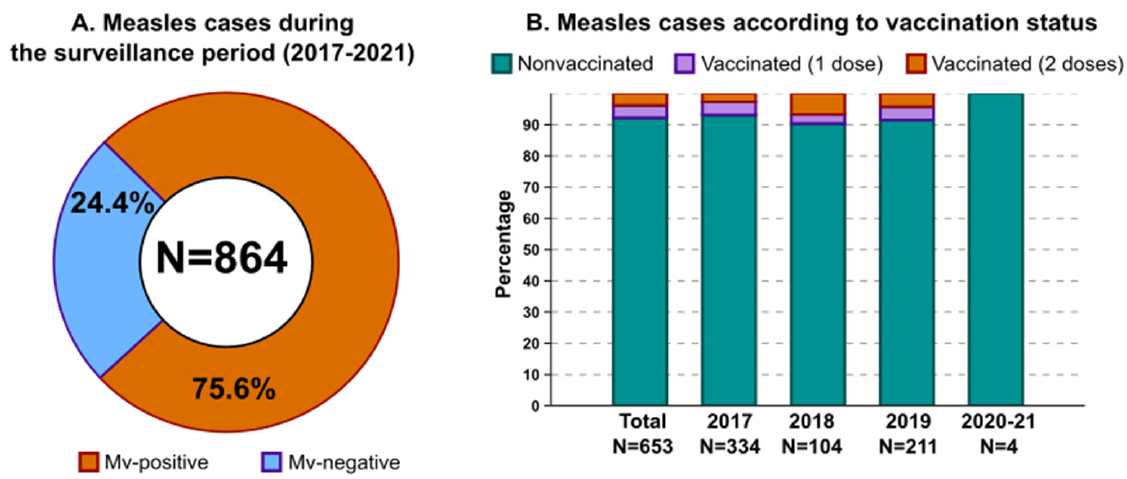
Figure 1. Measles cases in Milan and its surroundings (Northern Italy) during the years 2017–2021. ( A ) The proportion of measles cases identified during the study period. ( B ) The proportion of measles cases according to vaccination status and year of sample collection.